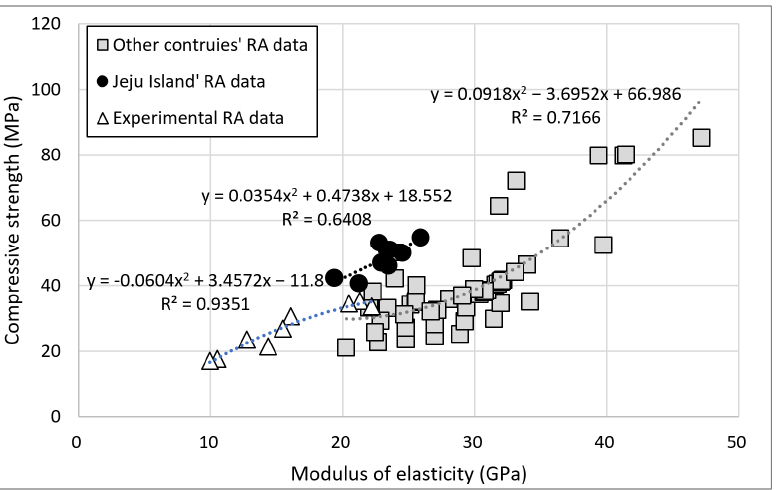
Figure 11. Relationship between compressive strength and the modulus of elasticity for domestic and overseas B-RA concrete.